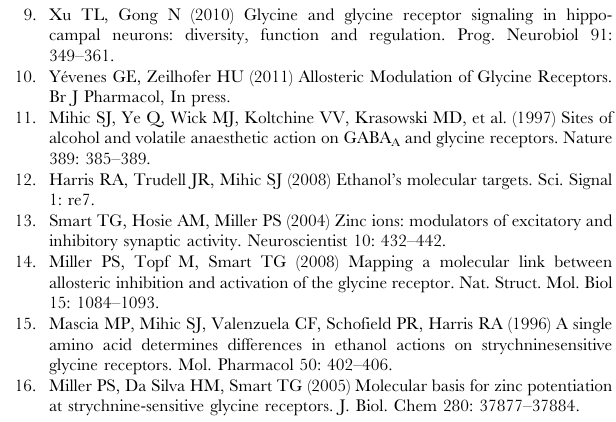
Figure S1 Endocannabinoid sensitivity of different GlyR subtypes. Concentration-response curves for ECs in wild-type